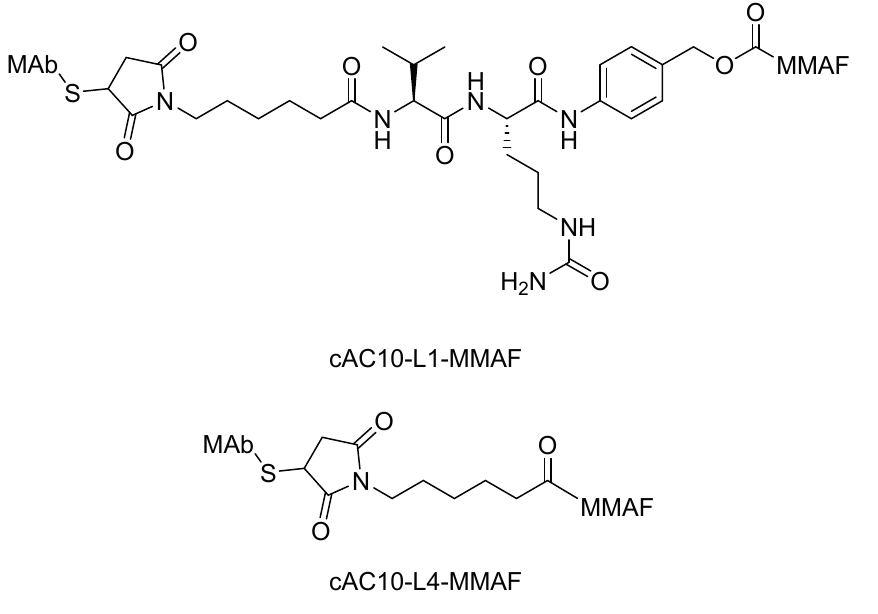
Figure 8. The structural formulas of cAC10-L1-MMAF and cAC10-L4-MMAF. Adapted from Reference